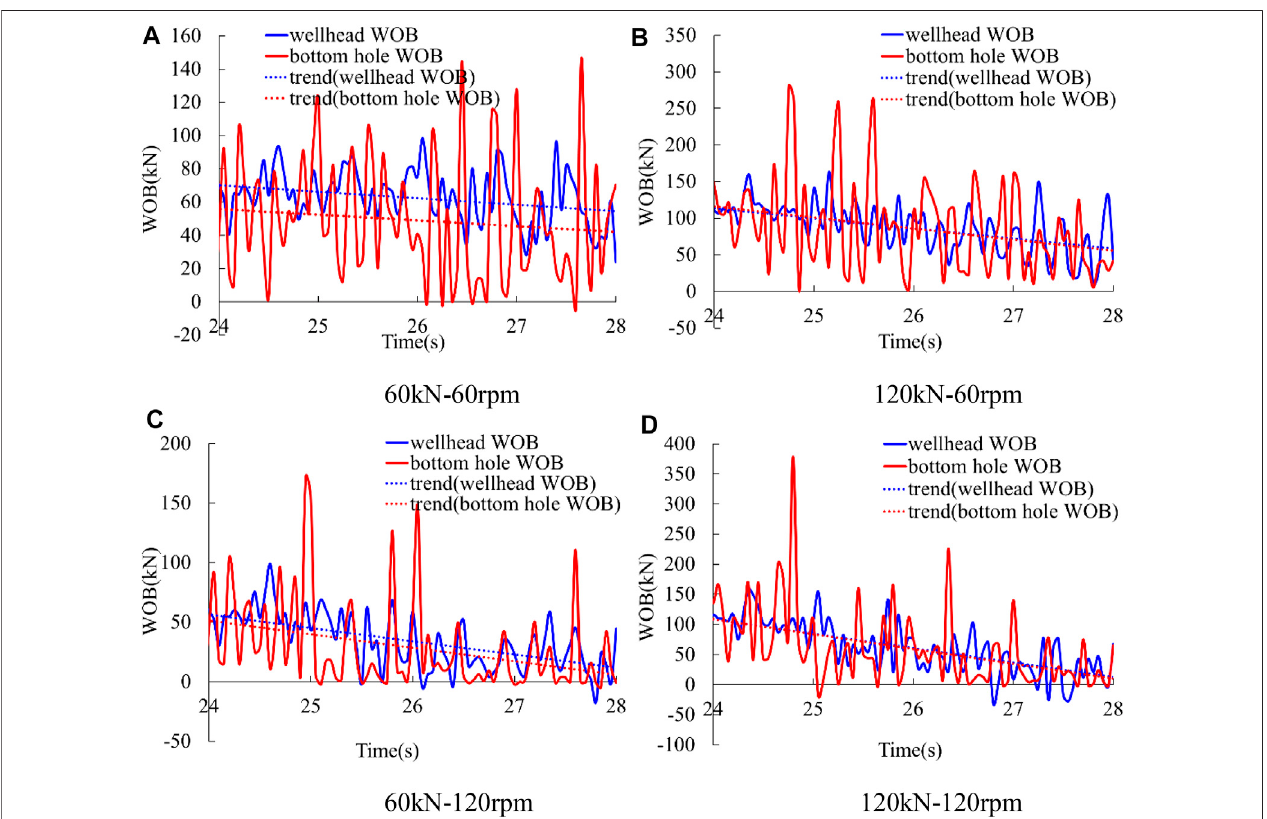
FIGURE 12 | Wellhead WOB and bottom hole WOB.